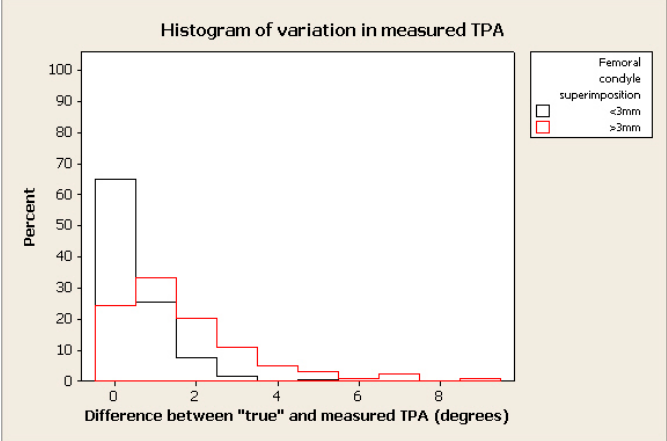
Figure 4. Histogram of % of frequency of measurements of TPA measured with femoral superimposition with <2 mm in difference between “true” and measured TPA in black and >2 mm in red.